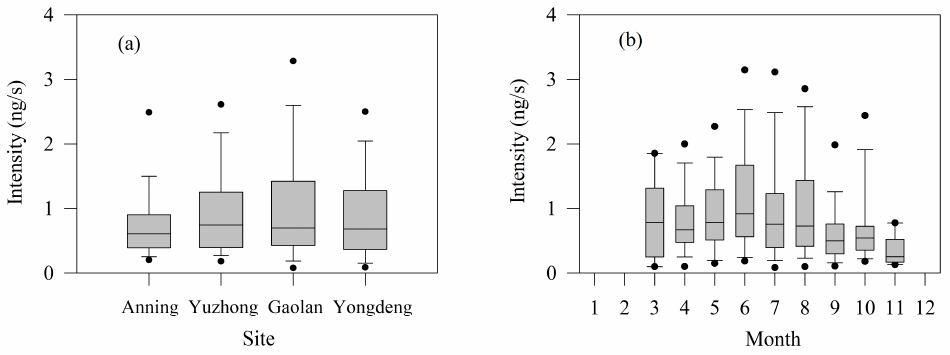
Figure 4. Regional ( a ) and monthly ( b ) variations of raindrop evaporation intensity. Water 2021 , 13 , x FOR PEER REVIEW